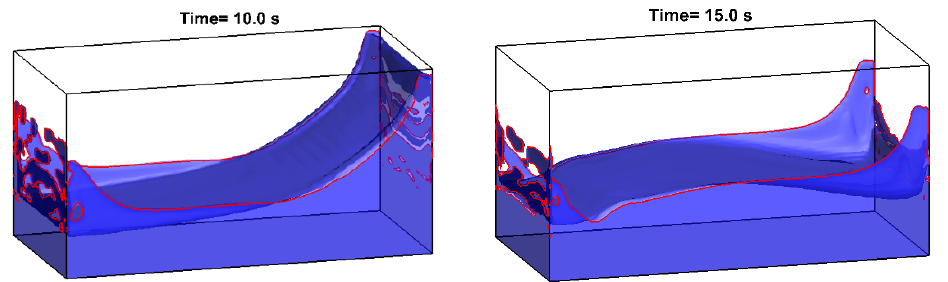
Figure 2. Numerical snapshots of the free surfaces at 2.5 s, 5.0 s, 10.0 s, and 15.0 s.